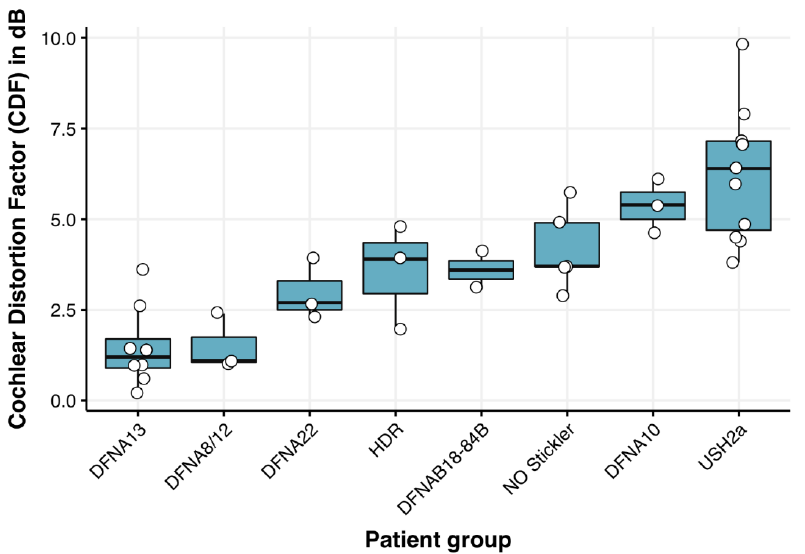
Figure 2. Boxplots of the eight patient groups, rank-ordered by the mean CDF for each group. The groups vary with respect to their mean CDF, but also with respect to the distribution within each group. The highest mean CDF (i.e., poorest speech understanding in noise) and the broadest distribution of individual patients’ CDF-values can be observed in the USH2a group. CDF = 0 means normal speech understanding in noise.